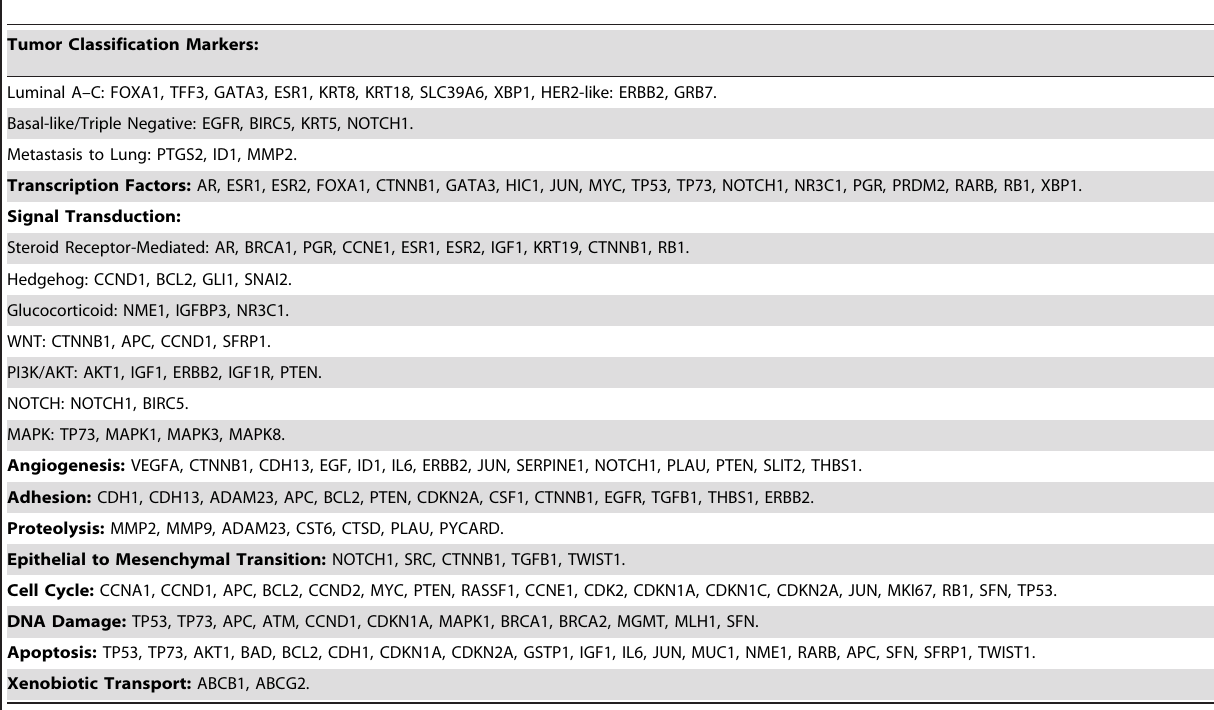
Table 2. Functional grouping of the 84 genes analyzed in the Human Breast Cancer PCR Array.